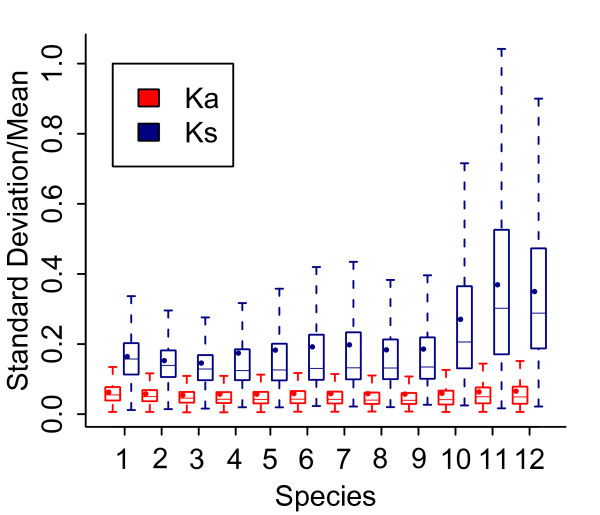
Divergence index (standard deviation/mean) of Ka and Ks determined based on the eight different methods from the twelve vertebrate species. In the boxplots, lower quantile, median, and upper quantile were represented in the boxes. Mean values were depicted in dots. Outliers were removed to make the plot straightforward. The number codes for the vertebrate species are: 1, chimp; 2, orangutan; 3, macaque; 4, horse; 5, dog; 6, cow; 7, guinea pig; 8, mouse; 9, rat; 10, opossum; 11, platypus; and 12, chicken.